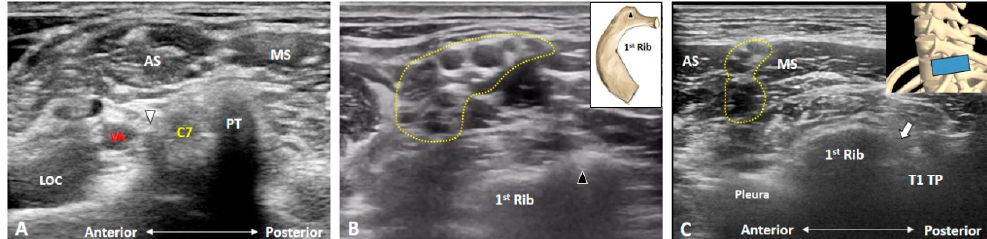
Figure 3. The C7 transverse process usually has only one posterior tubercle. In certain cases,